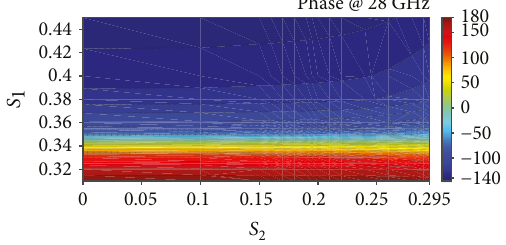
Figure 5: Simulated re fl ection phase vs. S